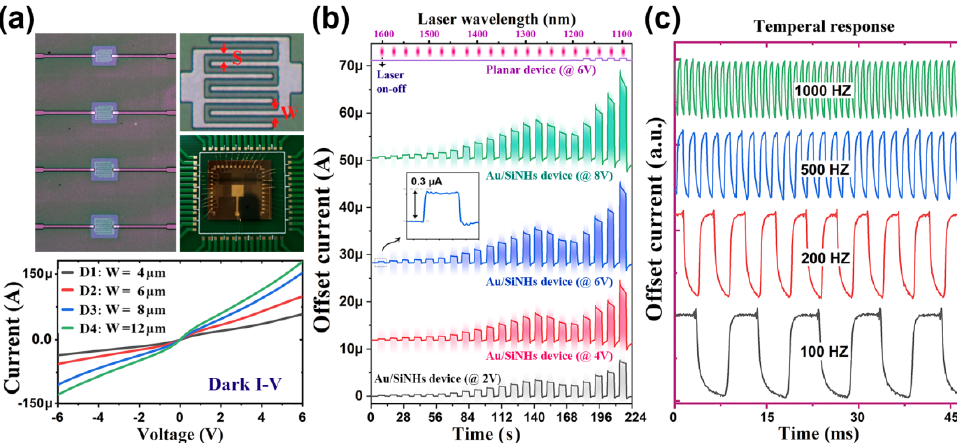
Figure 4. ( a ) Microscope images and typical dark I–V curves of the MSM devices. ( b ) Wavelength and time-dependent photoresponse of the Au-SiNH device (D4) under different voltage biasing conditions. The inset is the enlarged plot of the low photoelectric response regime. To ease the comparison, the result of the planar reference device biased at 6 V is also given in the plots. ( c ) The temporal current response for the device (D4) illuminated by the modulated incidence with different chopping